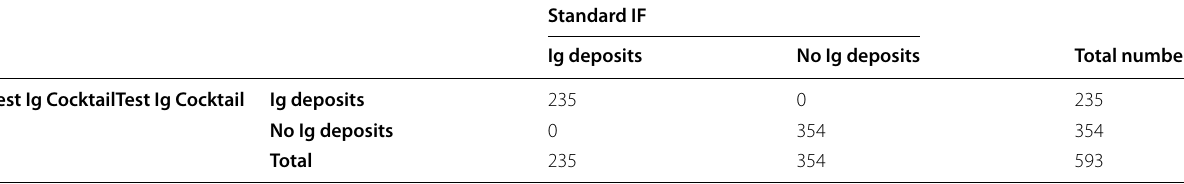
Table 3 Truth table for calculating sensitivity, specificity, positive and negative predictive values: